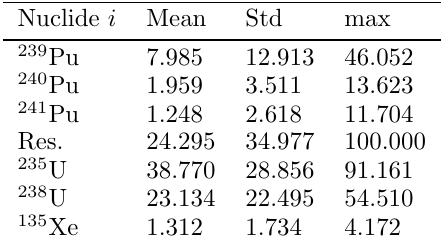
Fig. 5. Ratio of standard deviation (Std) over mean values of the pin-wise cross sections of all nuclides in the MOX dataset. Table 2. Mean, Std and maximum values of the fractions f i for neutron absorption of some nuclides from the UGd dataset.